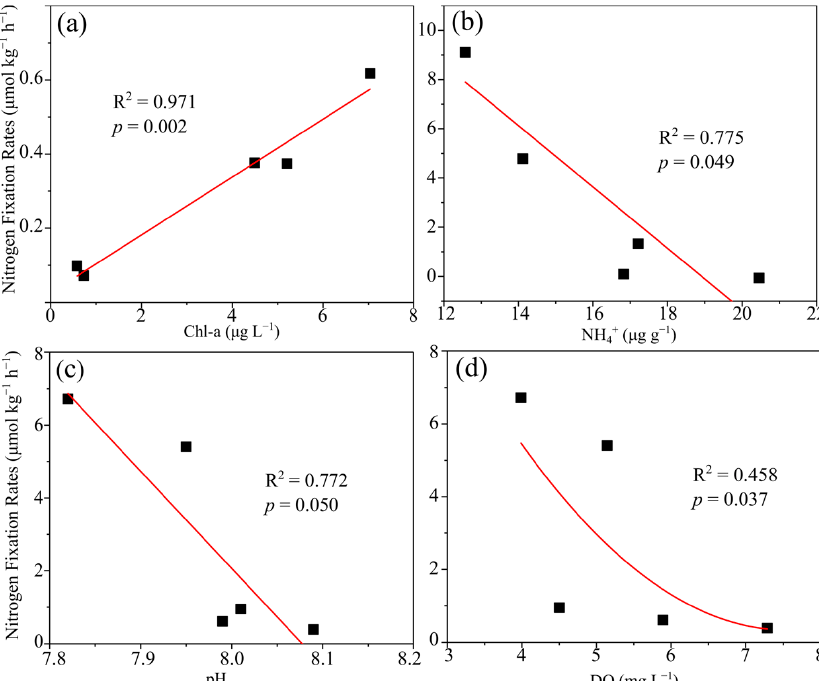
Figure 6. Scatter plots of significant correlations between nitrogen fixation rate and environmental parameter. ( a ) The correlation between NF and Chl- a content of overlying water at site 17. ( b ) The correlation between NF and sediment NH 4+ at site 18. ( c , d ) The correlations of NF with overlying water pH and DO at site S9.